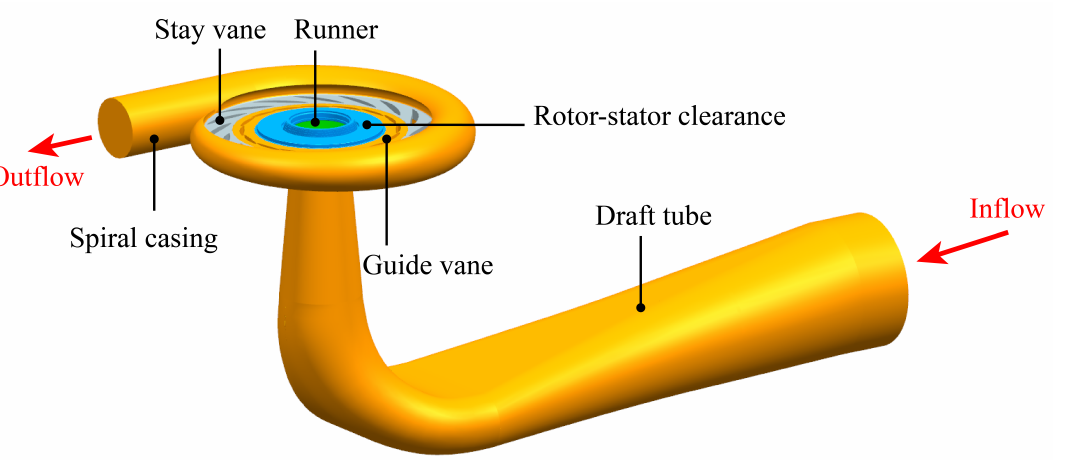
Figure 1. The main flow passage components of a pump turbine (pump mode).